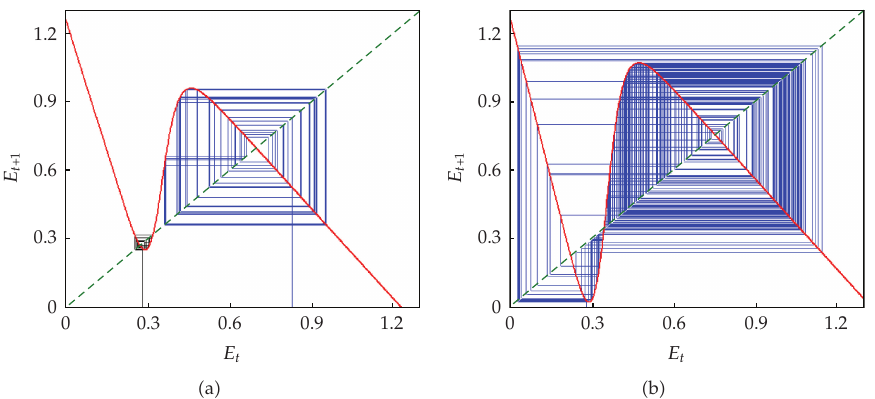
Figure 4: (cid:5) a (cid:6) Two chaotic trajectories starting from 0.83 to 0.28 (cid:5) A (cid:8) 0.86 (cid:6) . (cid:5) b (cid:6) Enlargement of the attractor (cid:5) A (cid:8) 1.29 (cid:6)